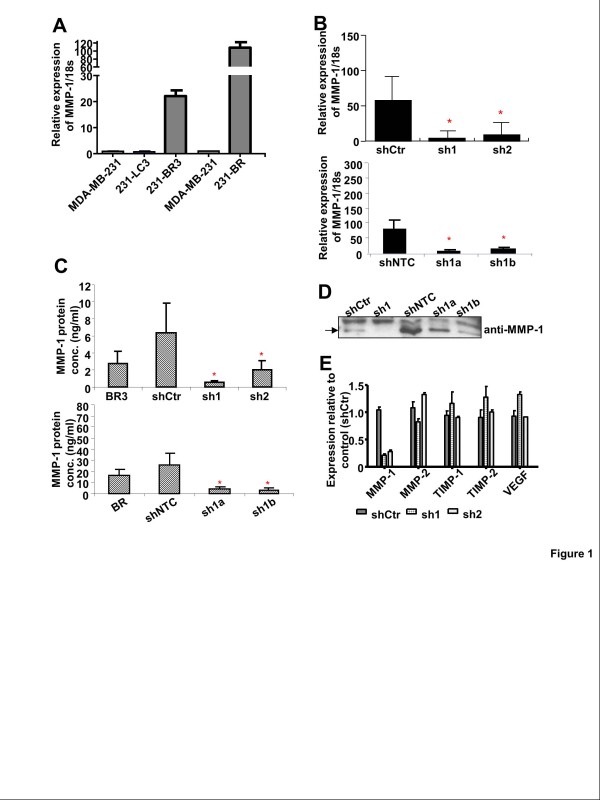
MMP-1 shRNAs specifically inhibit MMP-1 expression in BR3 and BR cells. A, real-time PCR quantification of MMP-1 mRNA levels. Compared with MDA-MB-231 parental cells and variants LC3 (selected from experimental lung metastases), the brain metastasis-derived BR3 and BR cells showed high levels of MMP-1 expression. This data shown are representative of 3 independent experiments. B, MMP-1 shRNAs knocked down MMP-1 mRNA level in BR3 and BR cell lines, compared with shCtr and shNTC cells expressing control shRNA. This experiment was performed in triplicate. C, ELISA assays and D, western blotting showed that MMP-1 protein levels in conditioned media were significantly reduced in BR3 and BR expressing MMP-1 targeting shRNA. These experiments were performed in triplicate. E, MMP-1 shRNA did not affect the expression of MMP-2, TIMP-1, TIMP-2 and VEGF in sh1 cells. This data shown are representative of 3 independent experiments.